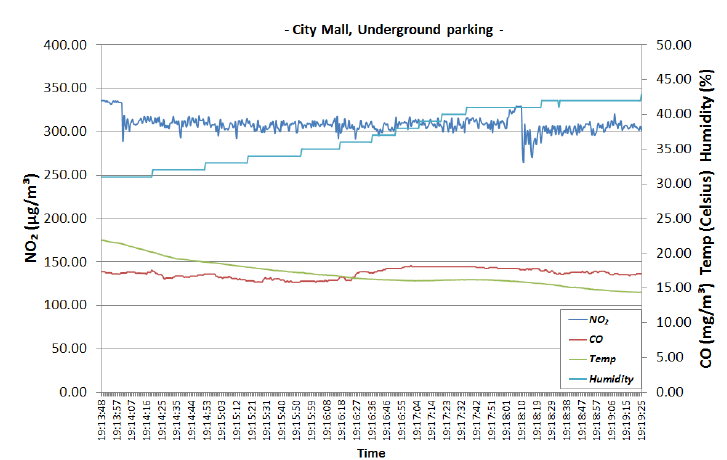
Figure 16. City mall underground parking—second time